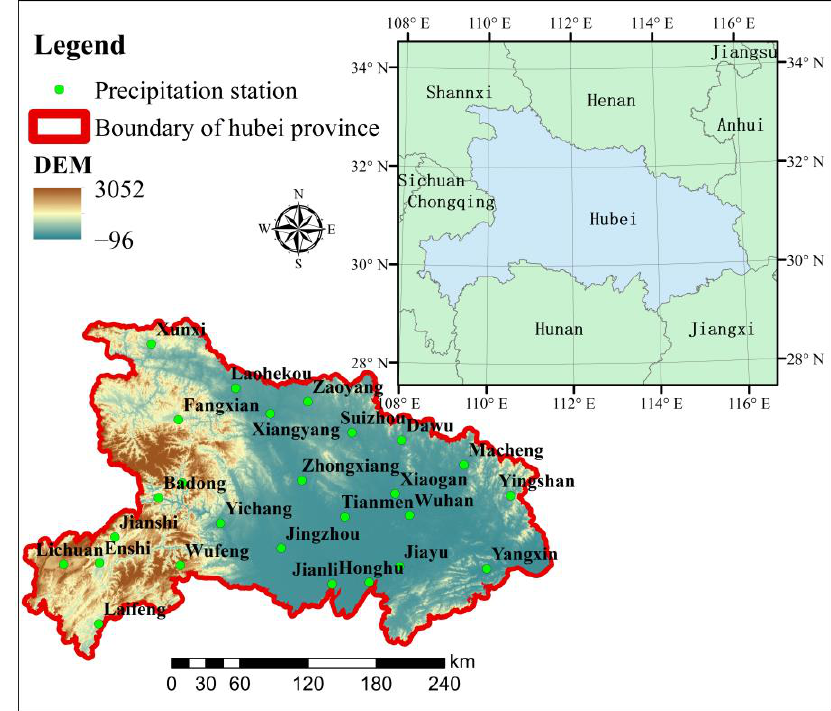
Figure 1. Overview of the Hubei province, China.